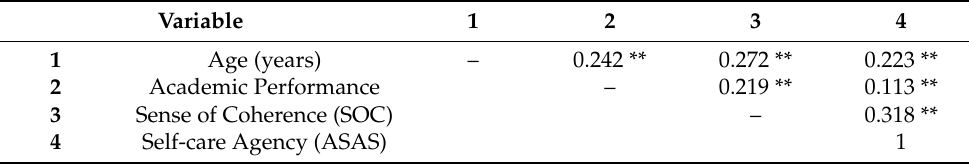
Table 3. Bivariate (Pearson) correlations among study